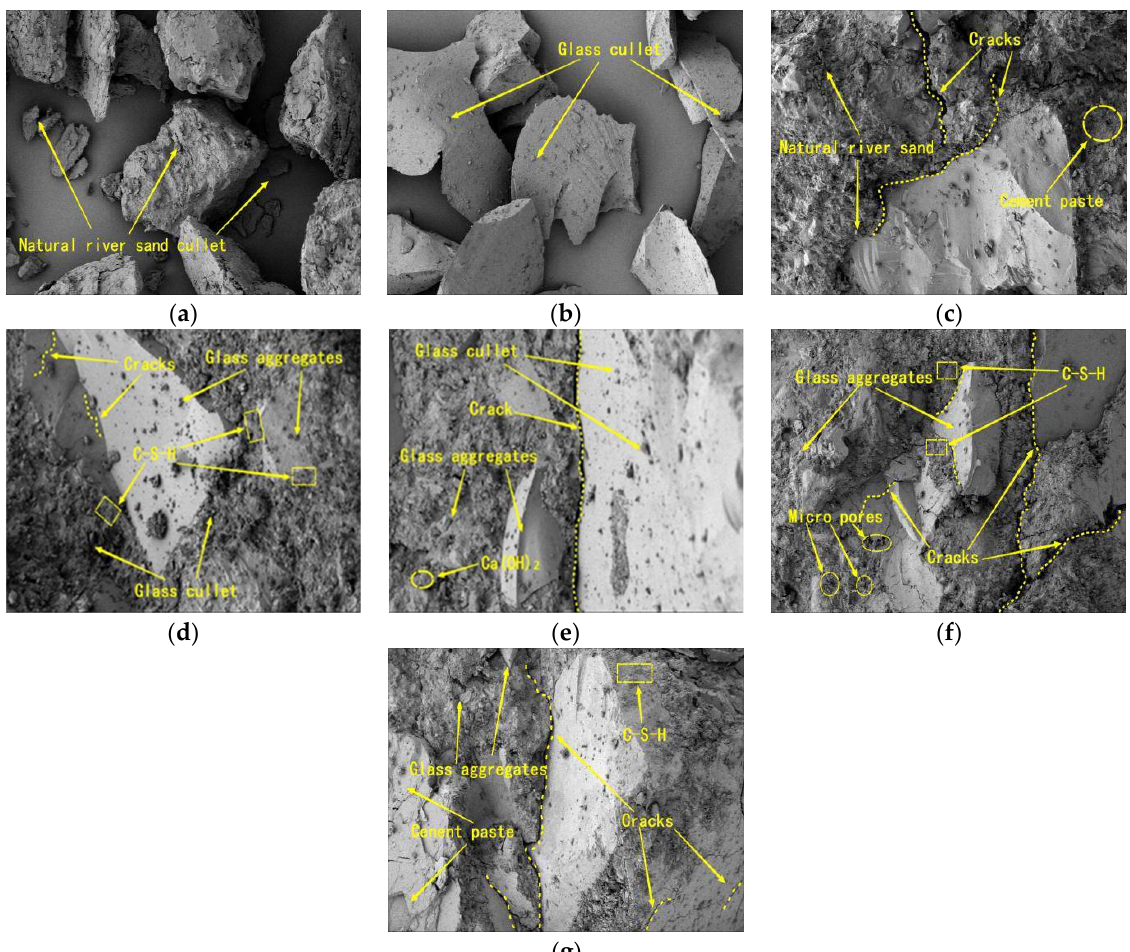
Figure 13. Scanning electron micrograph of mortar: ( a ) natural river sand; ( b ) waste glass sand; ( c ) B0; ( d ) B20; ( e ) B40; ( f ) B60; ( g ) B80.